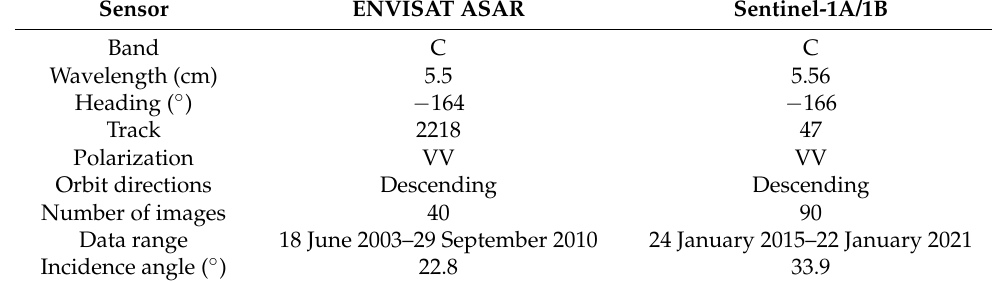
Table 1. Information of the SAR dataset.